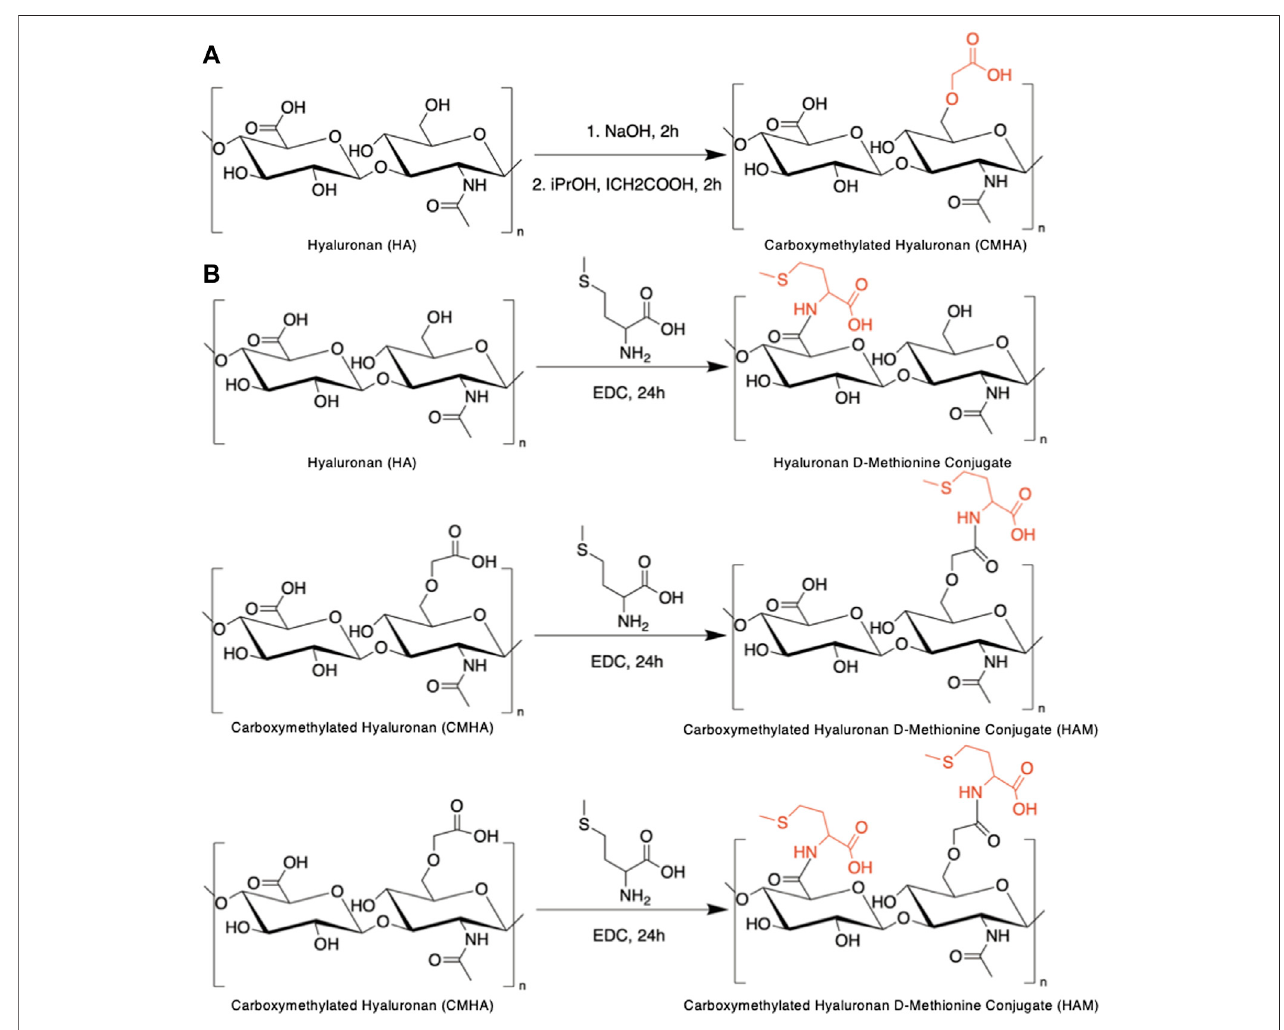
FIGURE1| SynthesesofHAMconjugate. (A) Reactionschemeforthechemicalfunctionalizationofhyaluronicacid(HA)toyieldcarboxymethylatedhyaluronicacid (CMHA). (B) Conjugation of D -Methionine to CMHA to yield the hyaluronan- D -Methionine conjugate (HAM).